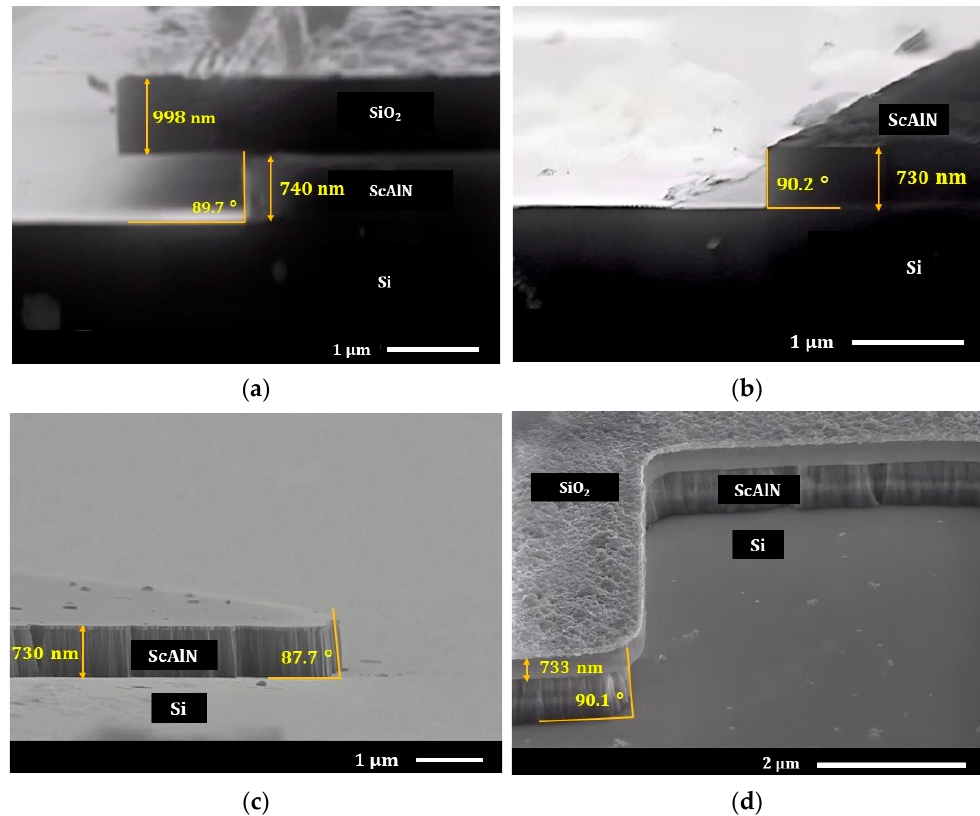
Figure 3. Scanning electron microscope (SEM) images of ( a ) Sc 0.20 Al 0.80 N after 3 min of TMAH etching at 80 ◦ C, ( b ) Sc 0.20 Al 0.80 N after hard mask (SiO 2 ) removal, ( c ) Sc 0.20 Al 0.80 N after hard mask (SiO 2 ) removal with different feature, and ( d ) Sc 0.20 Al 0.80 N after TMAH etching with the sample prepared in negative tone (Inverted